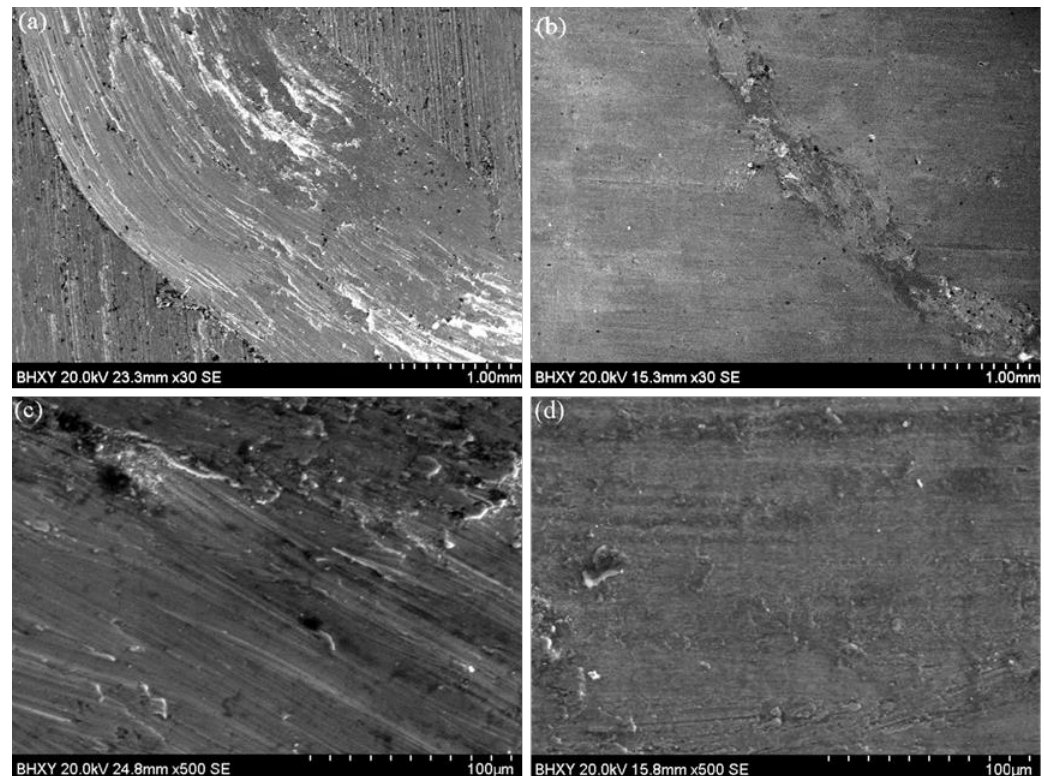
Figure 10. Wear surface morphologies of the substrate ( a , c ) and the coating ( b , d ).